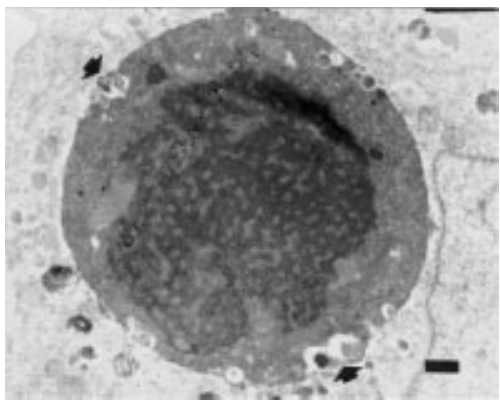
Fig. 10. Microcell bud in the cytoplasm of a macrocell. Arrows point to sites of a microcell enclosing particles of the macrocell. Bar 0.5 (cid:22)